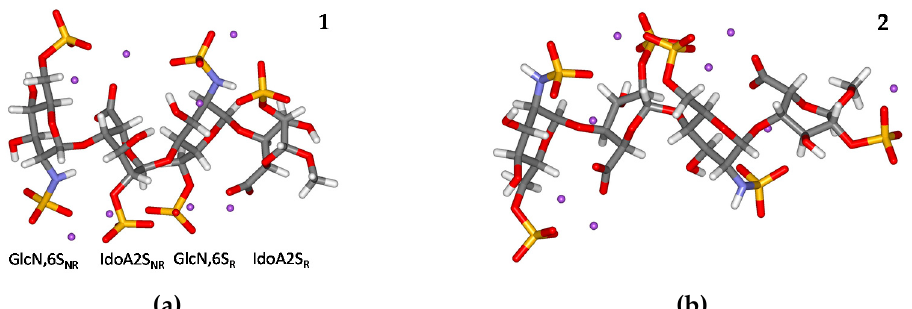
Figure 1. The chemical structure of the heparin tetrasaccharide.